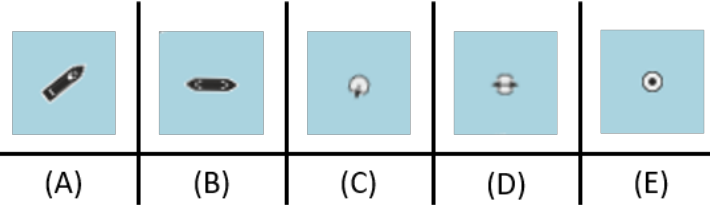
Figure 15. Vessel and target classes: ( A ) identified vessel, with recognized route; ( B ) identified vessel, with recognized direction only (route is known up to a 180 ◦ ambiguity); ( C ) detected target, with recognized route; ( D ) detected target with recognized direction (route is known up to a 180 ◦ ambiguity); and ( E ) detected target, with no information about route or direction.